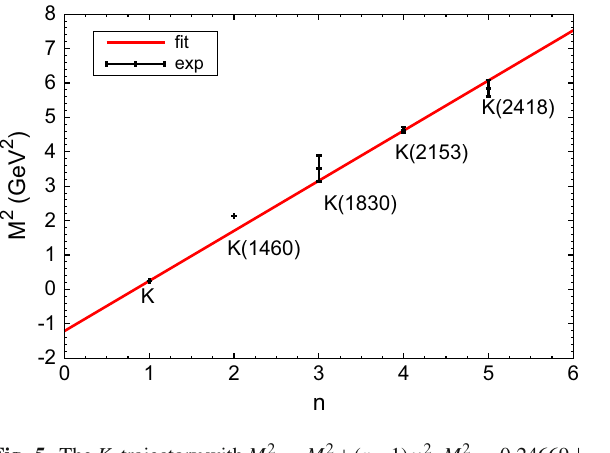
Fig. 5 The K -trajectorywith M 2 n = M 2 0 . 00002GeV 2 , μ 2 = 1 . 456 ± 0 . 026GeV 2 , χ 2 / d.o.f = 1 . 897 /( 4 − 2 ) . In our fit, the we don’t use the data of K ( 1460 ) since the K ( 1460 ) mass error is not given experimentally. The masses of the K and K ( 1830 ) are taken from Ref. [2]. The masses of the K ( 2153 ) and K ( 2418 ) are taken